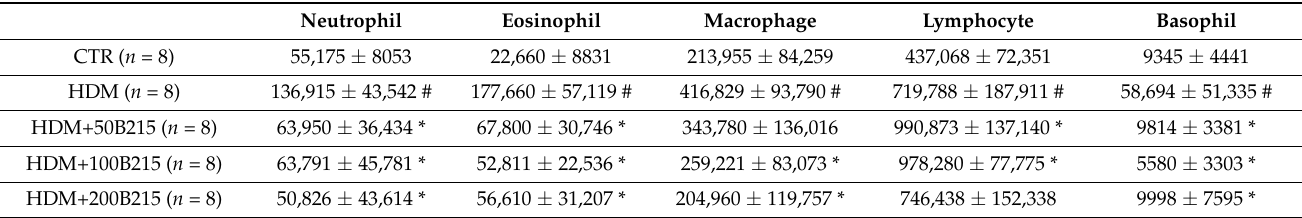
Table 3. Quantitative analysis of immune cell populations in